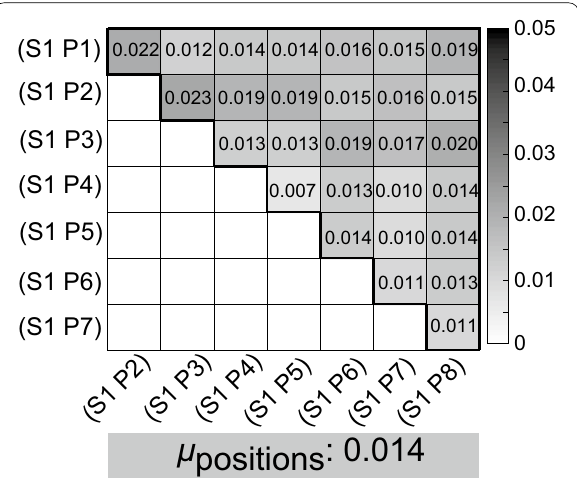
Fig. 10 Stability against for position change